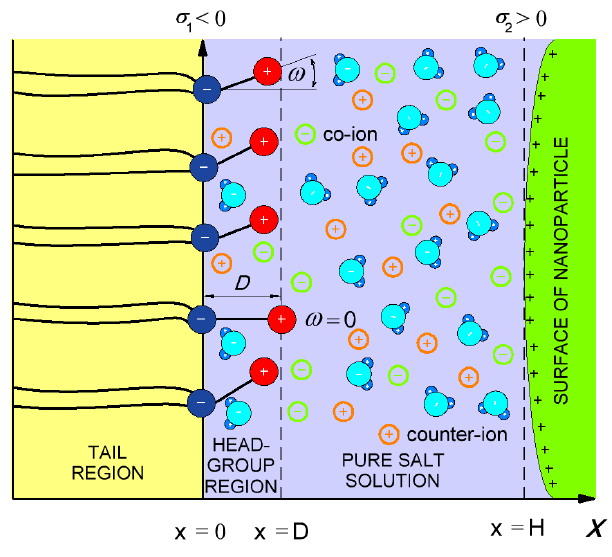
Figure 4. Negative charges of dipolar (zwitterionic) lipid headgroups are described by the surface charge density, (cid:27) , at x = 0 . The positive charges of the headgroups of dipolar lipids 1 protrude in the electrolyte solution. Here, D , is the distance between the charges within the single dipolar lipid headgroup, and ! describes the orientation angle of the dipole within the single headgroup. The positive charge of the interacting nanoparticle is described by the surface charge density, (cid:27) . 2